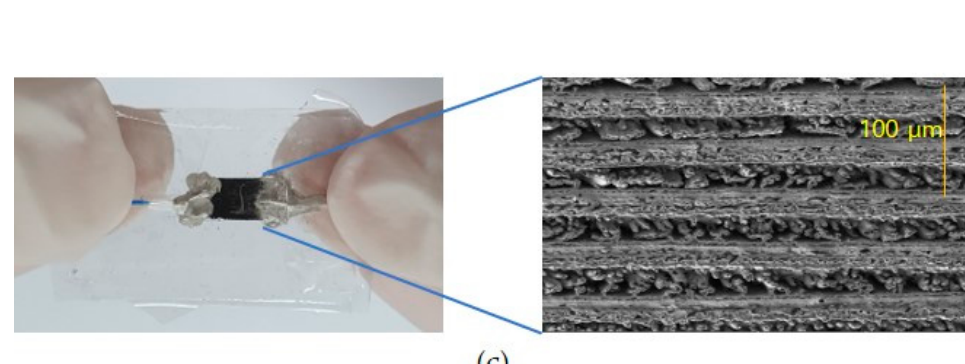
Figure 6. Photographs of the strain sensor under ( a ) twisting and ( b ) bending; ( c ) SEM image of carbonized pattern embedded on polydimethylsiloxane (PDMS).